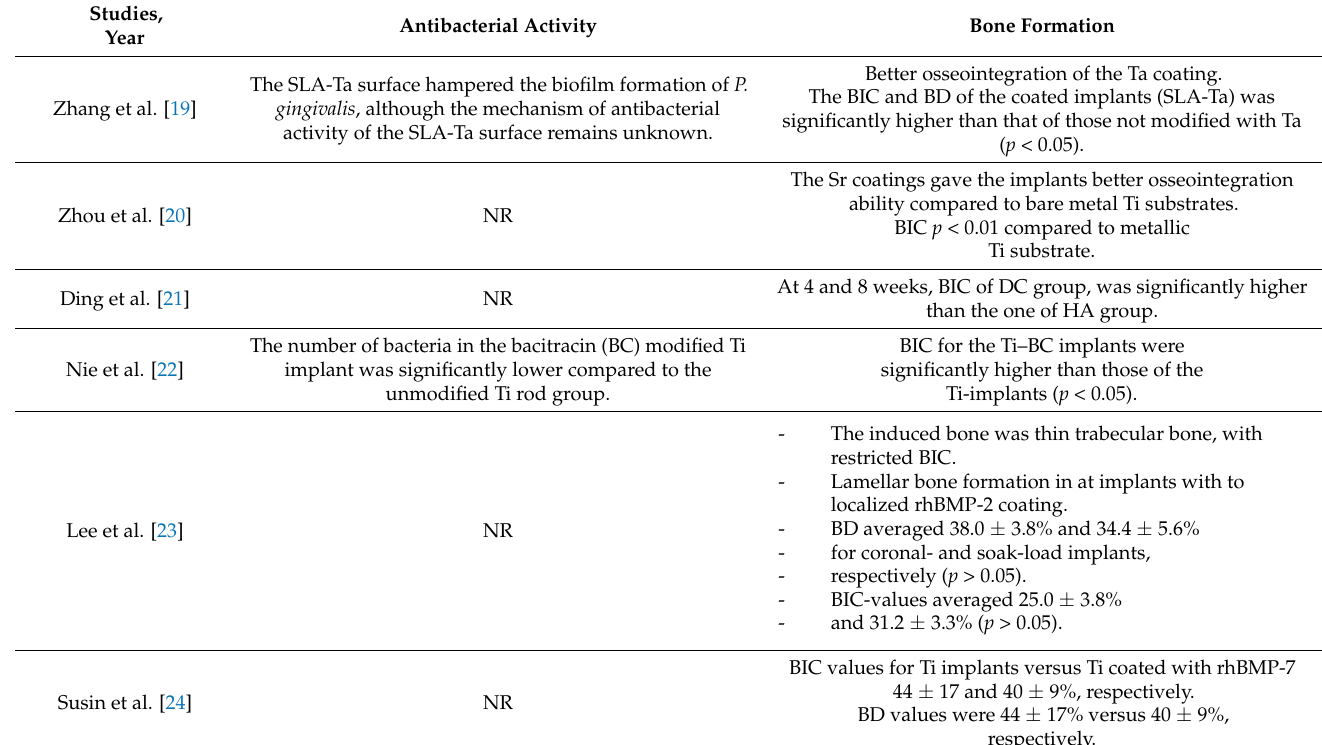
Table 3. Antibacterial activity and bone formation in vivo.